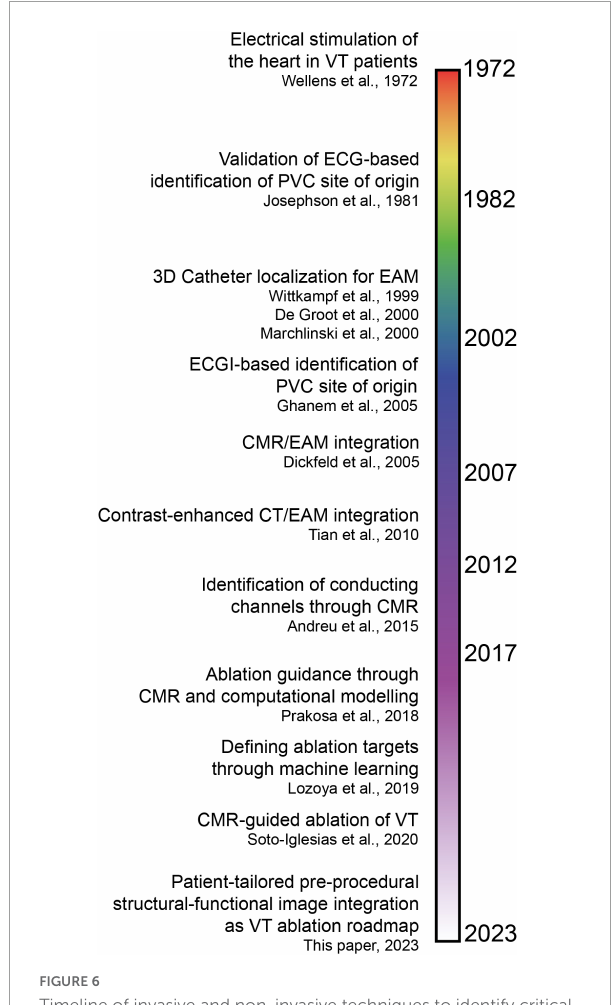
FIGURE6 Timeline of invasive and non-invasive techniques to identify critical components of the ventricular tachycardia (VT) circuit and guide catheter ablation (7, 15, 31–33, 35–38, 43, 44). Note that the time axis is not linear, which is reflected by the color gradients. ECG, electrocardiogram; PVC, premature ventricular complex; EAM, electroanatomical mapping; ECGI, electrocardiographic imaging; CMR, cardiac magnetic resonance imaging; CT, computed